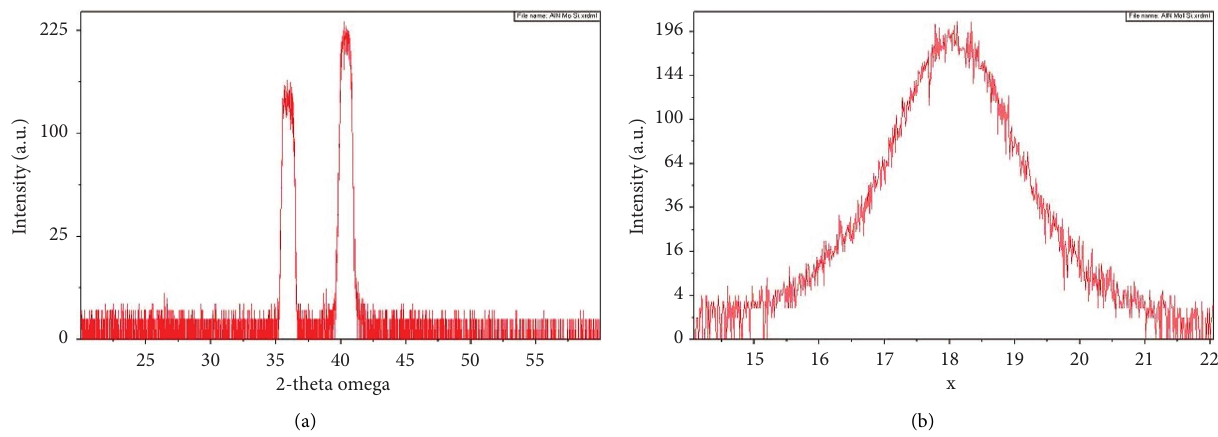
Figure 5: X-ray difraction (XRD) patterns of the AlN thin flm, (a) 2 θ scan; (b) χ scan of the AlN (002)